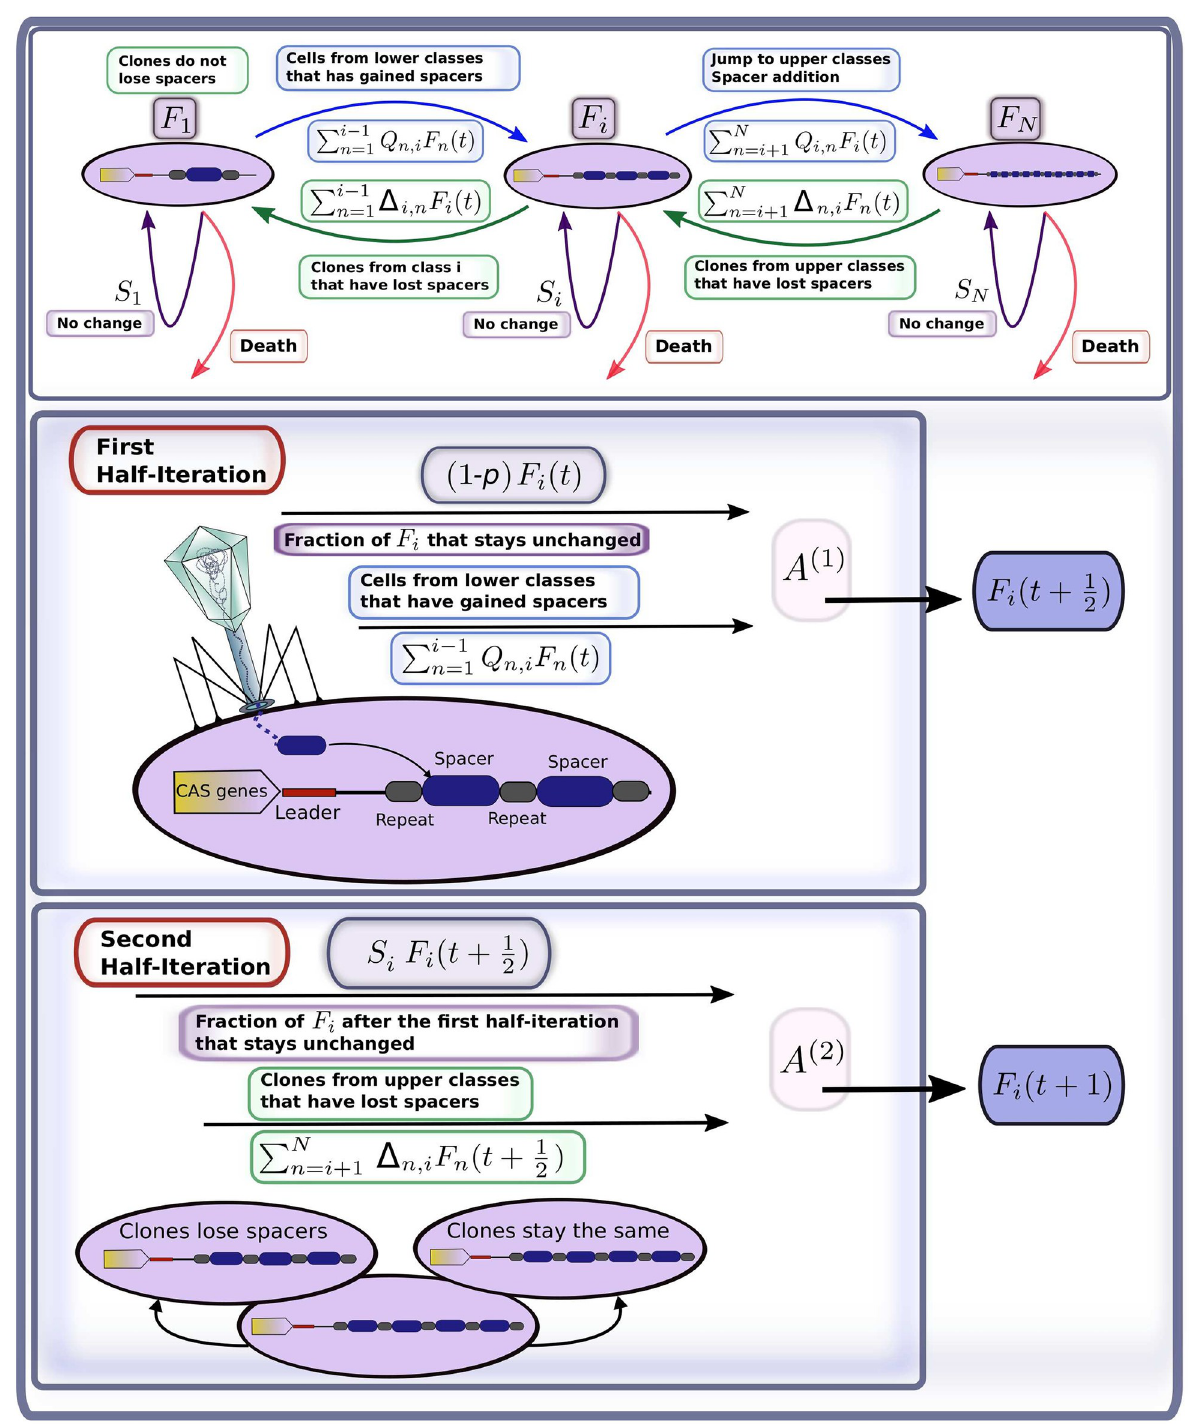
Fig 1. Simplified flowchart of the mathematical model: Adjustment of class size i at time iteration t . The first half-iteration describes the infection in the case the cell meets a phage (with probability p ). Possible outcomes of this stage are: gaining j − i spacers (with probability Q i , j ), death of the cell, and survival without gaining any spacers (with probability 1 − p ). The second half-iteration mimics the replication stage. Replication can result in loss of i − j spacers in the daughter cell. The parent cell is assumed to always keep the same number of spacers. The loss or conservation of spacers number at this stage are described, respectively, by Δ j , i and S i . Details on the parameterization of Q i , j , Δ j , i , and S i are provided in the supplementary material.